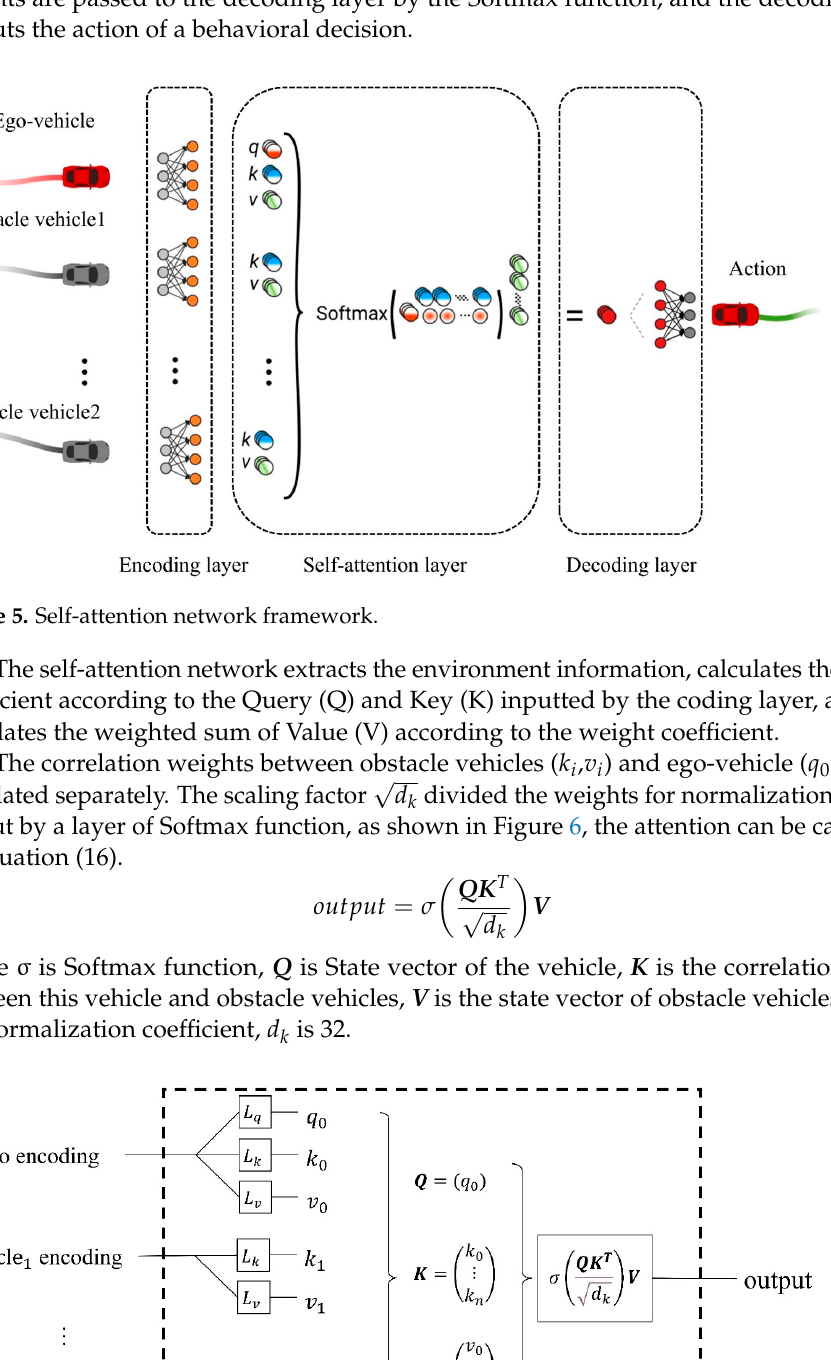
Figure 4. Interval prediction in roundabout.